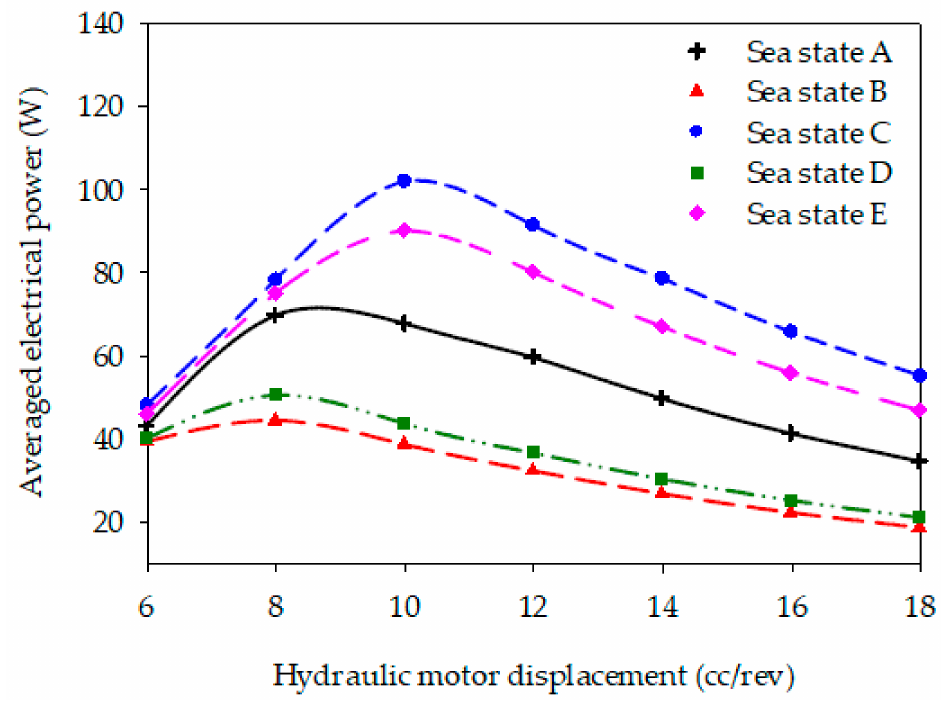
Figure 12. Averaged power of generator versus fluid displacement of HM corresponding to different sea